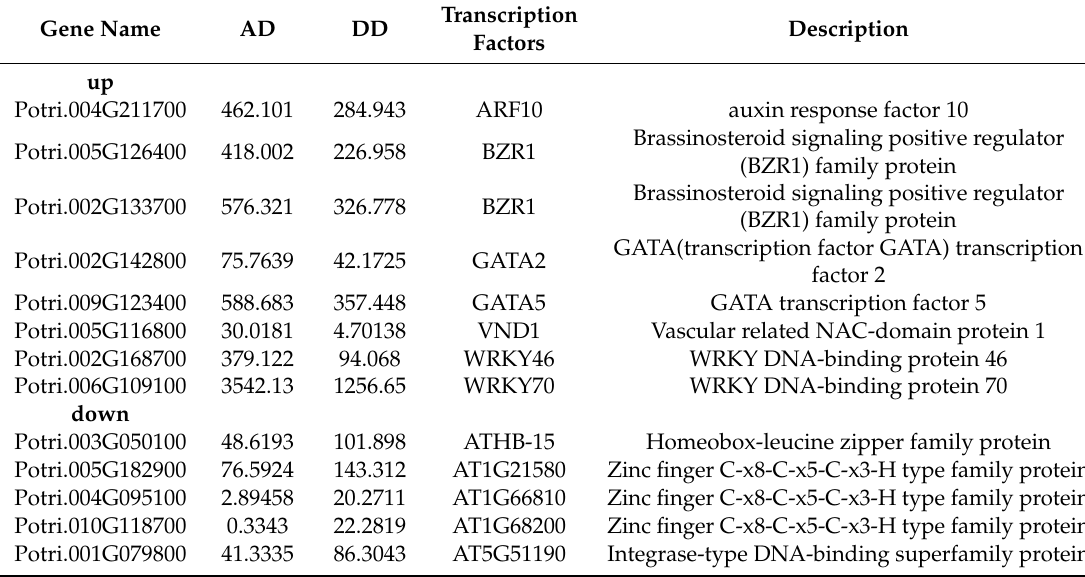
Table 2. Di ff erentially expressed transcription factors at 09:00.